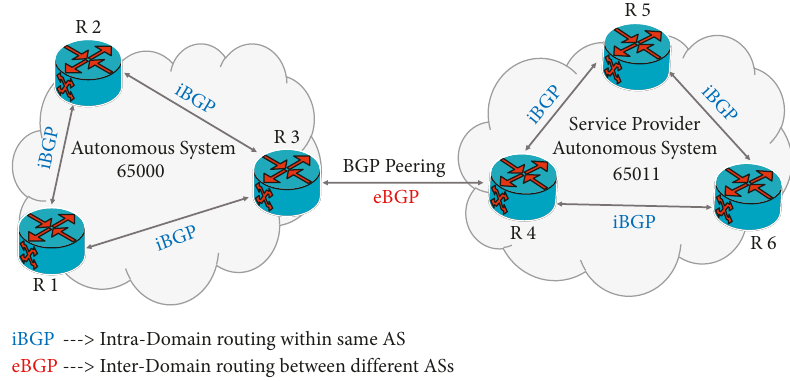
Figure 10: Example of an intra- and interdomain routing